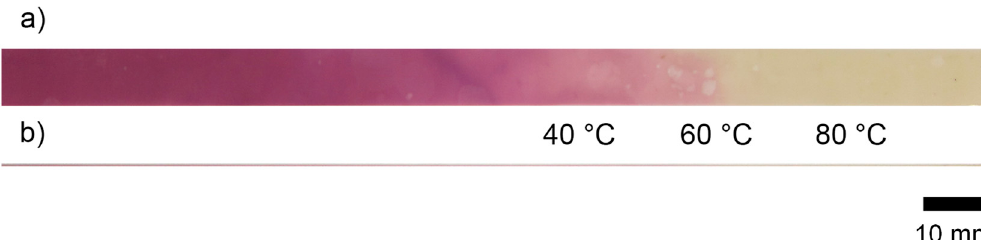
Figure 3. ( a ) Ribbon and ( b ) fiber of an UHMWPE–[Fe(NH 2 trz) 3 ](2ns) 2 blend comprising 33.3% m / m [Fe(NH 2 trz 3 )](2ns) 2 . The ribbon was prepared by gel-processing with stearic acid as a solvent, followed by extraction of stearic acid in diethyl ether, and the fiber by gel-spinning (see above). The samples were placed on a Kofler bench, i.e., a heating bench that features a temperature gradient.